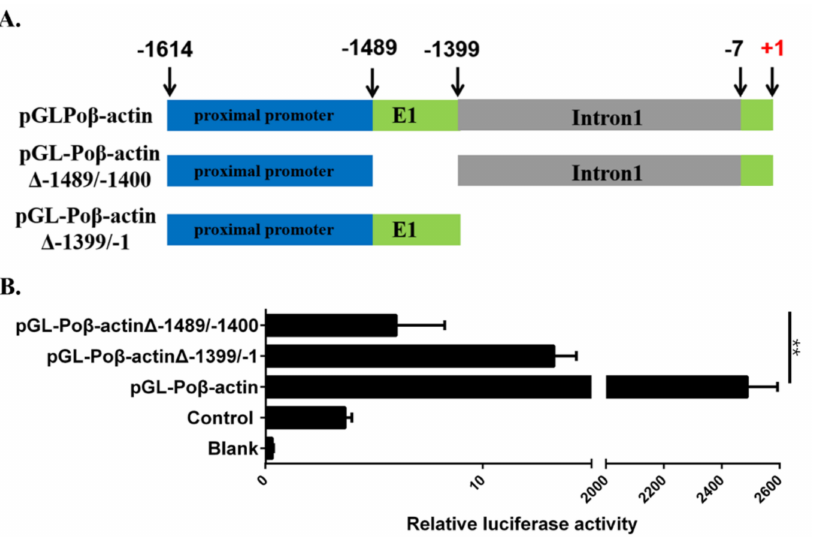
Figure 3. Examination of activity of 5 (cid:48) -upsream sequences, first exon and first intron of the Japanese flounder β -actin gene based on a reporter assay. ( A ) A schematic diagram of promoter region of luciferase reporter gene constructs. Showing various 5 (cid:48) -flanking sequence sequences of Japanese flounder β -actin gene fused with luciferase gene. ( B ) The relative levels of reporter gene expression in FEC cells are shown. The constructs were transiently cotransfected into cells along with pRL-tk control vector. The activity of firely and Renilla luciferase in the cell lysate were measured using a dual-luciferase reporter assay (Promega) at 48 h post transfection. Firefly luciferase activity was normalized to Renilla luciferase activity. The bars indicated mean ± S.D. of luciferase activity ( n = 3). ** indicates statistical significance ( p <